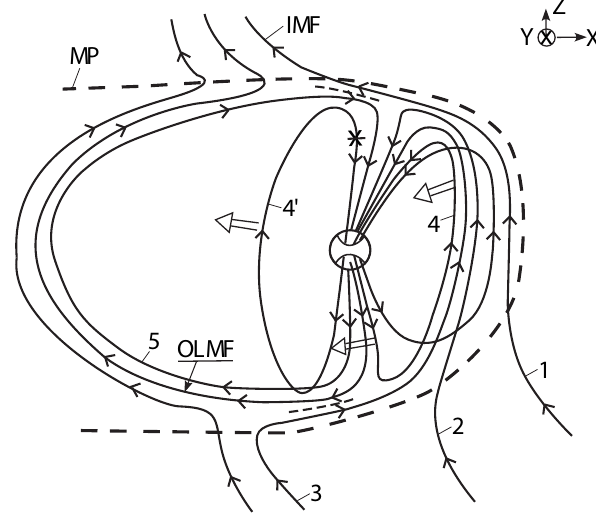
Fig. 3. Schematic illustration of magnetospheric magnetic flux cy- cle (marked 1–5) involving (i) high-latitude (lobe) reconnection in the north, (ii) overdraped lobe flux and (iii) internal reconnection between the overdraped lobe flux and open geomagnetic field lines in the south at the dawn side during north IMF orientation (the IMF B x < 0 case). The perspective is from the dawn side of the magne- tosphere. The position of spacecraft Polar at mid-altitudes on the dawn side in relation to the field line topology are indicated by star. Adapted after Alexeev et al. (2008). Not to